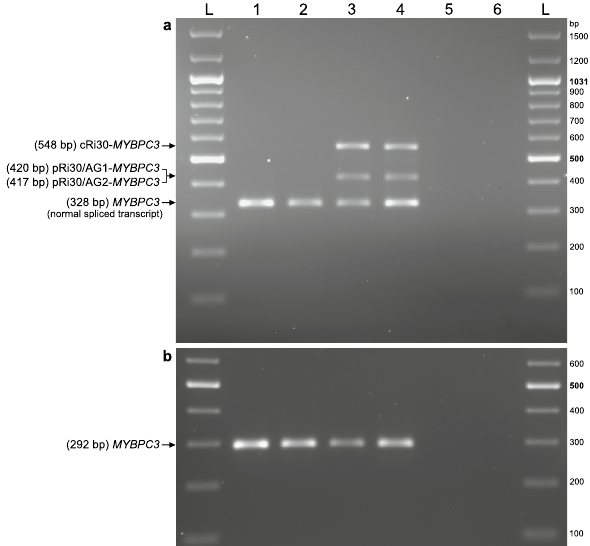
Figure 6. RT ‐ PCR analysis of MYBPC3 expression in patients’ blood. ( a ) Agarose gel electrophoresis of RT ‐ PCR products of blood RNA isolated from non ‐ carriers (lane 1 ‐ III.7, lane 2 ‐ III.1) and carriers (lane 3 ‐ III.4, lane 4 ‐ III.6) of the MYBPC3 c.3331−26T>G variant in intron 30. This splicing assay targeted the MYBPC3 mRNA region between exons 30–31 using the primer pair 543–542. Negative controls were loaded in lane 5 (RT −) and 6 (non-template). The lower bands (328 bp) correspond to normal MYBPC3 mRNA (Supplementary Fig. S13). The longer bands from both III.4 and III.6 correspond to a misspliced transcript with the complete retention of intron 30 (548 bp, cRi30 ‐ MYBPC3 , Supplementary Fig. S13). Sequence analysis revealed that the intermediate ‐ sized RT ‐ PCR bands actually contained two transcripts, with partial retention of intron 30 (Supplementary Fig. S14), named pRi30/AG1 (420 bp) and pRi30/AG2 (417 bp), as previously shown by the minigene expression assay (see Fig. 3). ( b ) An additional RT-PCR assay targeting the MYBPC3 mRNA region between exons 2–3 with the primer pair 601–603 and the same cDNA samples was performed. This second assay was designed to analyze mRNA splicing in the presence of the MYBPC3 c.292+177C>T variant, located in intron 2, in carriers (lane 1 ‐ III.7, lane 2 ‐ III.1) and non-carriers (lane 3 ‐ III.4, lane 4 ‐ III.6). A single RT-PCR band of the expected size (292 bp) was detected in all lanes. Sanger sequencing of the purified 292-bp band confirmed that it corresponds to normal MYBPC3 mRNA (Supplementary Fig. S15). Full ‐ size RT ‐ PCR images are presented in Supplementary Fig. S12. L—DNA